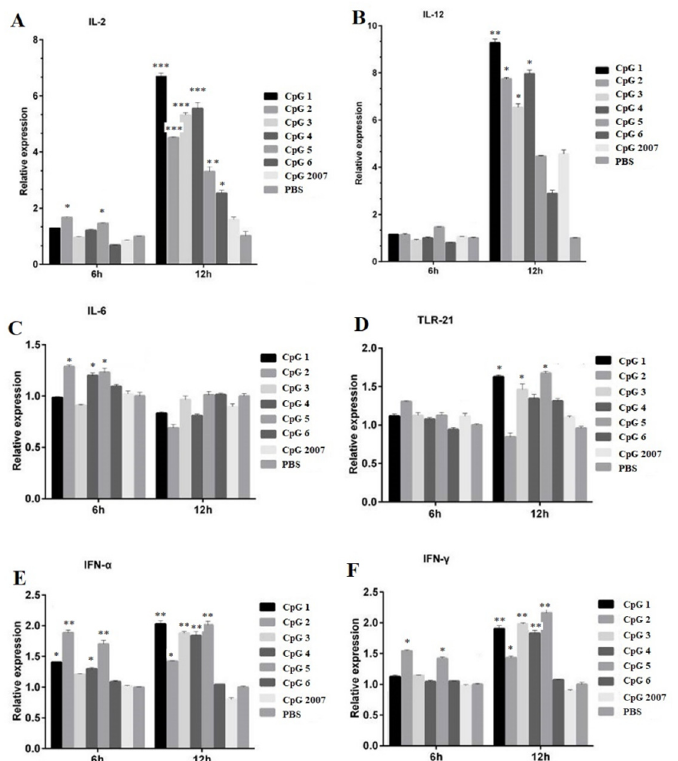
Figure 2. Effect of CpG on the mRNA expression of CEF related immune genes. CEFs were treated with 0.25 μ g/mL six CpGs and CpG2007 for 6 and 12 h. The expressions of IL-2 ( A ), IL-12 ( B ), IL-6 ( C ), TLR-21 ( D ), IFN- α ( E ) and IFN- γ ( F ) were detected with qPCR. All data were presented as mean ± SD. * p < 0.05, ** p < 0.01, and *** p <